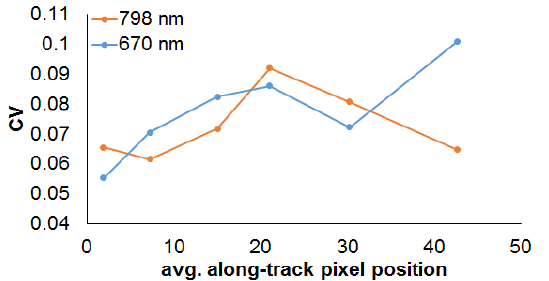
Figure 6 Coefficient of variation (CV) for image cubes 1 to 6 at 670nm and 798 nm in relationship to the average across-track pixel position of the